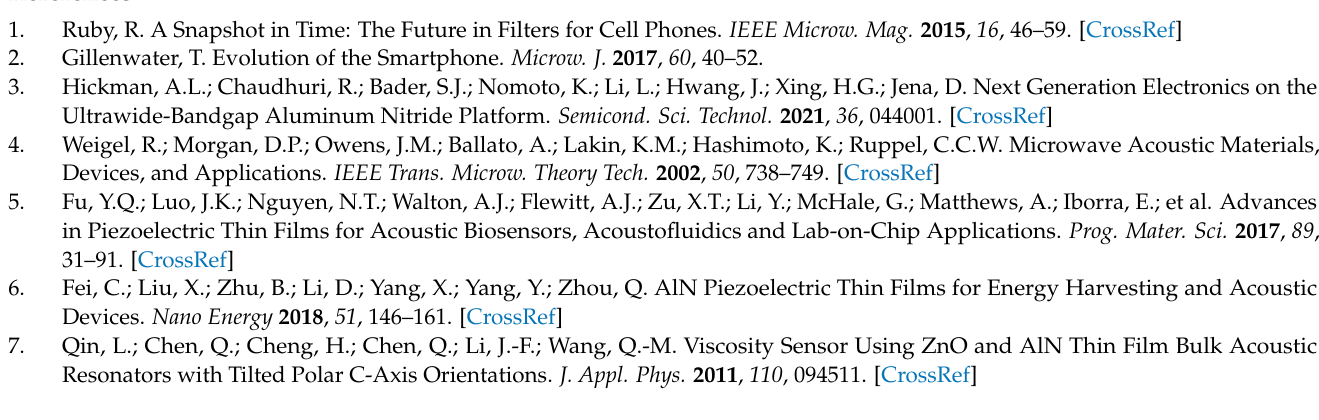
Table S1: Physical parameters of the materials utilized in the simulation; Table S2: Dopants considered in this study and the result of C 11 - C 12 , 2 C 132 - C 33 ( C 11 + C 12 ), C 66 . Reference [48] are cited in the supplementary